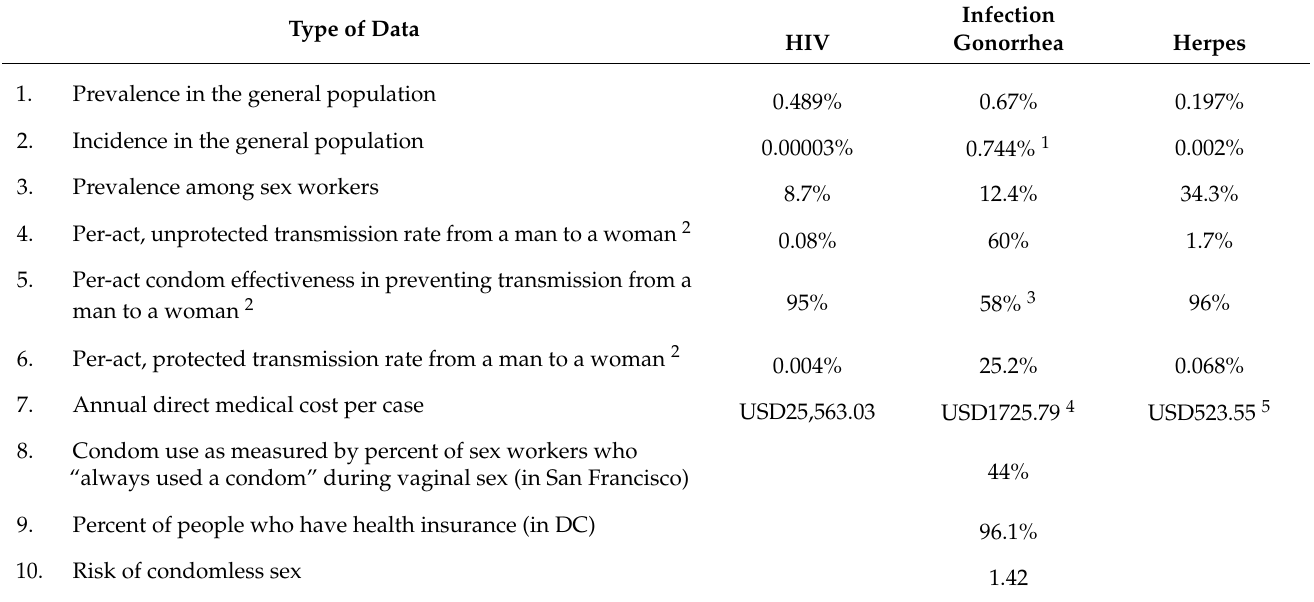
Table 4. Values of data used to calculate health sector savings due to averted cases of HIV, gonorrhea, and herpes in sex workers following decriminalization (monetary values in 2020 USD).